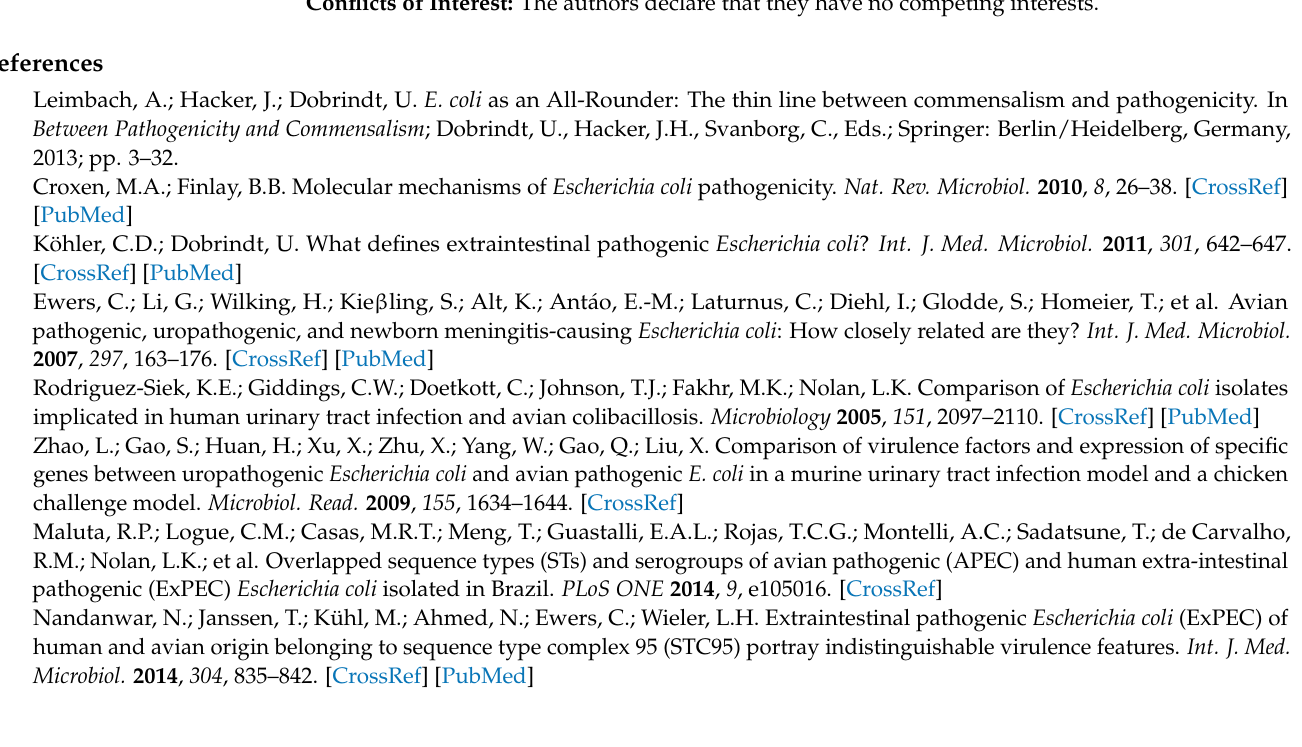
Figure S4. Association of antimicrobial resistance phenotypes, resistance genotypes, and biofilm production among the examined E. coli isolates. Blue and red boxes denote positive and negative correlations, respectively. Significant associations were calculated at p < 0.05; blank boxes denote non-significant